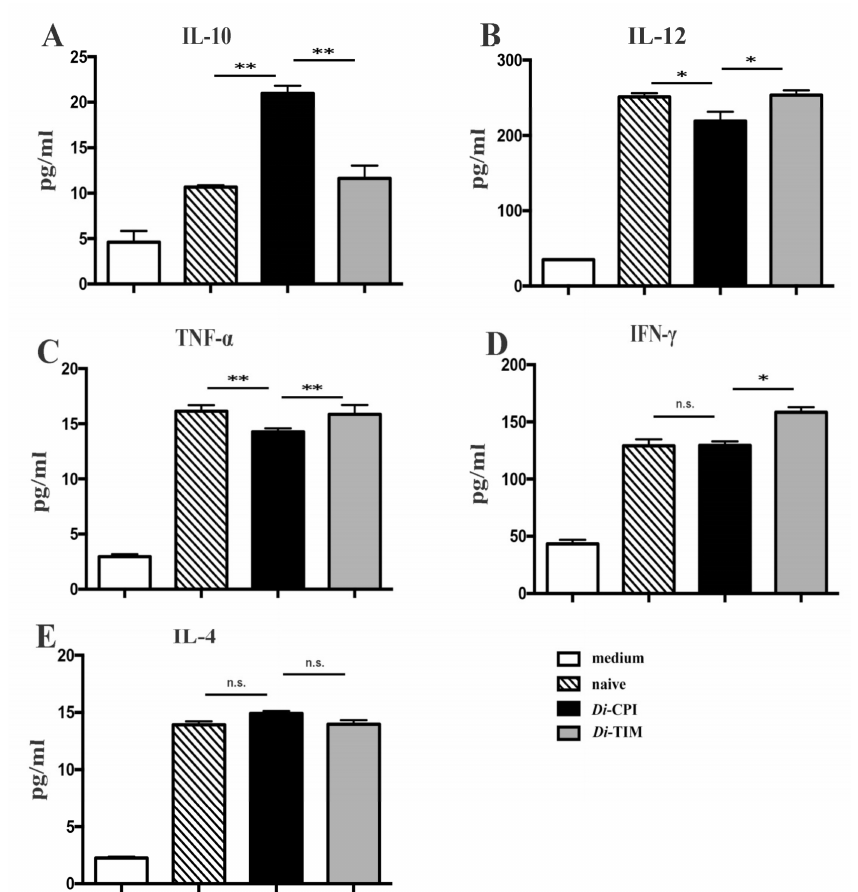
Figure 6. Analysis of cytokines following inhibition of canine PBMCs by Di -CPI. Supernatants of canine PBMCs stimulated for 48 h were subjected to ELISA to measure the concentration of IL-10, IL-12, TNF- α , IFN- γ , and IL-4. r Di -CPI treatment increased anti-inflammatory cytokine IL-10 ( A ), followed by significant decrease of the production of IL-12 ( B ) and TNF- α ( C ). IFN- γ ( D ) and IL-4 ( E ) showed no significant di ff erence compared with controls. Naive indicates no protein was added to wells. Data are mean ± SEM of 3 samples with triplicate wells; representative data from one of three independent experiments. n.s., not significant. Statistically significant di ff erences (* p < 0.05, ** p < 0.01) were determined by Mann–Whitney